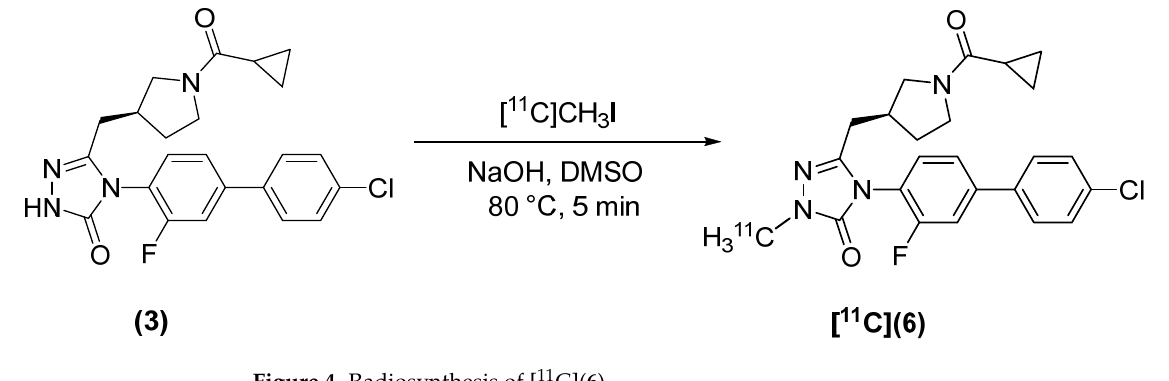
Figure 4. Radiosynthesis of [ 11 C]( 6 ).